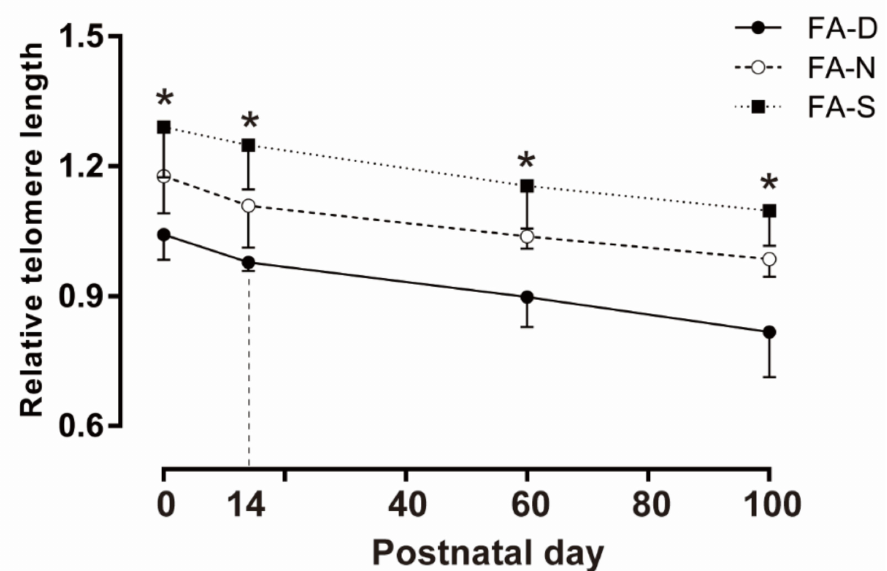
Figure 4. Folic acid supplementation alleviated telomere shortening in brain tissue of offspring. Dams and pups were fed as described in Figure 1. Brain tissue telomere length on PND0, PND14, PND60, and PND100 was quantified by qPCR. Data are expressed as mean ± SD ( n = 8 brains/group). * Comparing with three groups at α = 0.05/(comparison